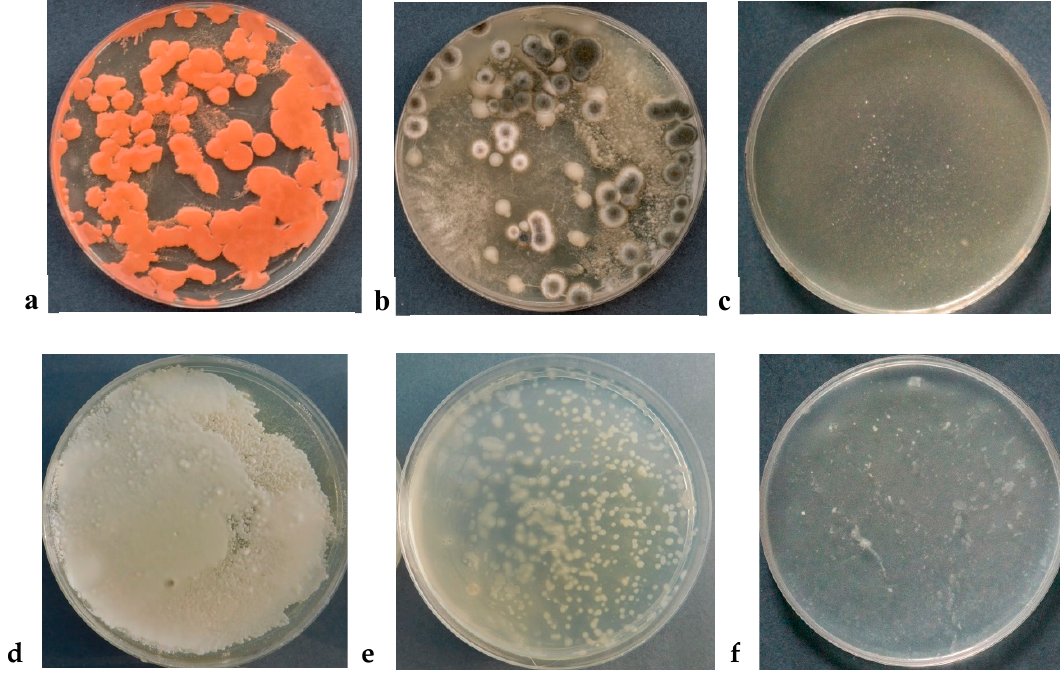
Figure 5. Fungi ( a – c ) and psychrophilic bacteria ( d – f ) cultured from the inner surface of the packaging of goat curd stored for two weeks at chilled temperature and wrapped in polyolefin foil with PLA coating (a,b,d,e) or polyolefin foil with ZVI/PLA coating (c,f).